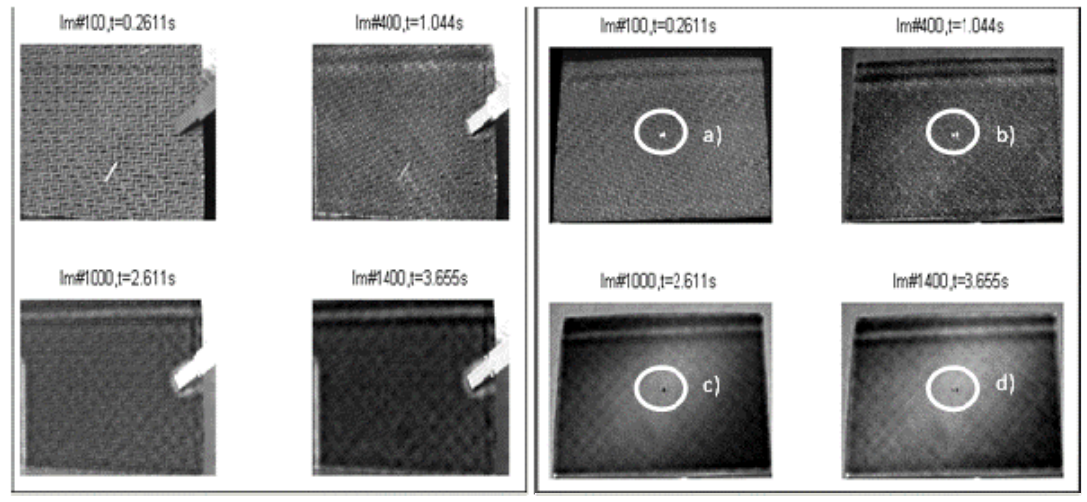
Figure 13. Thermography analysis after impact testing at 3 J; ( left ) top side up; and ( right ) bottom side up; the second derivative of